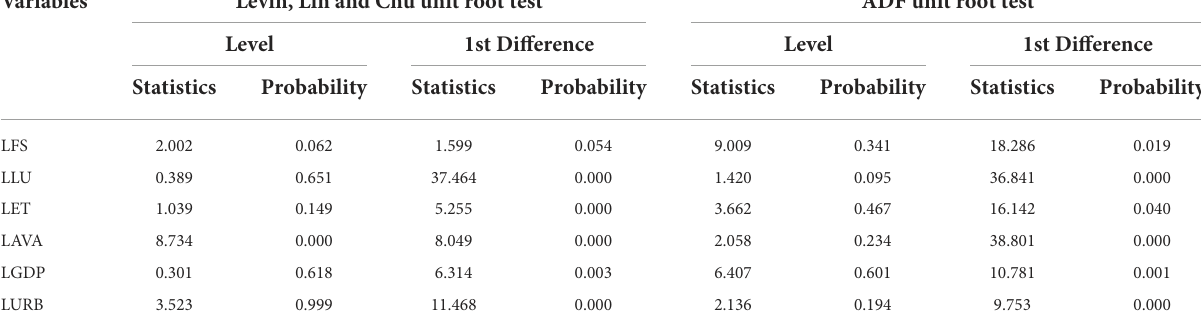
TABLE 4 Levin, Lin and Chu, and ADF unit root